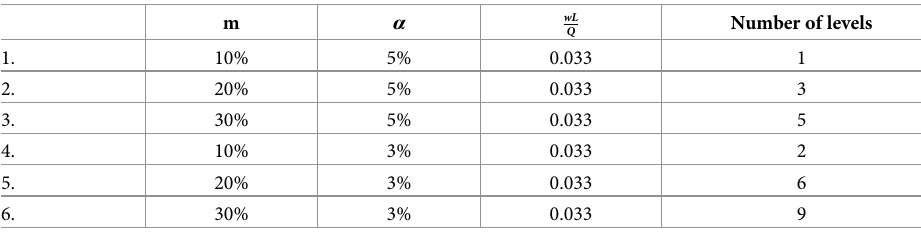
Table 1. Comparative